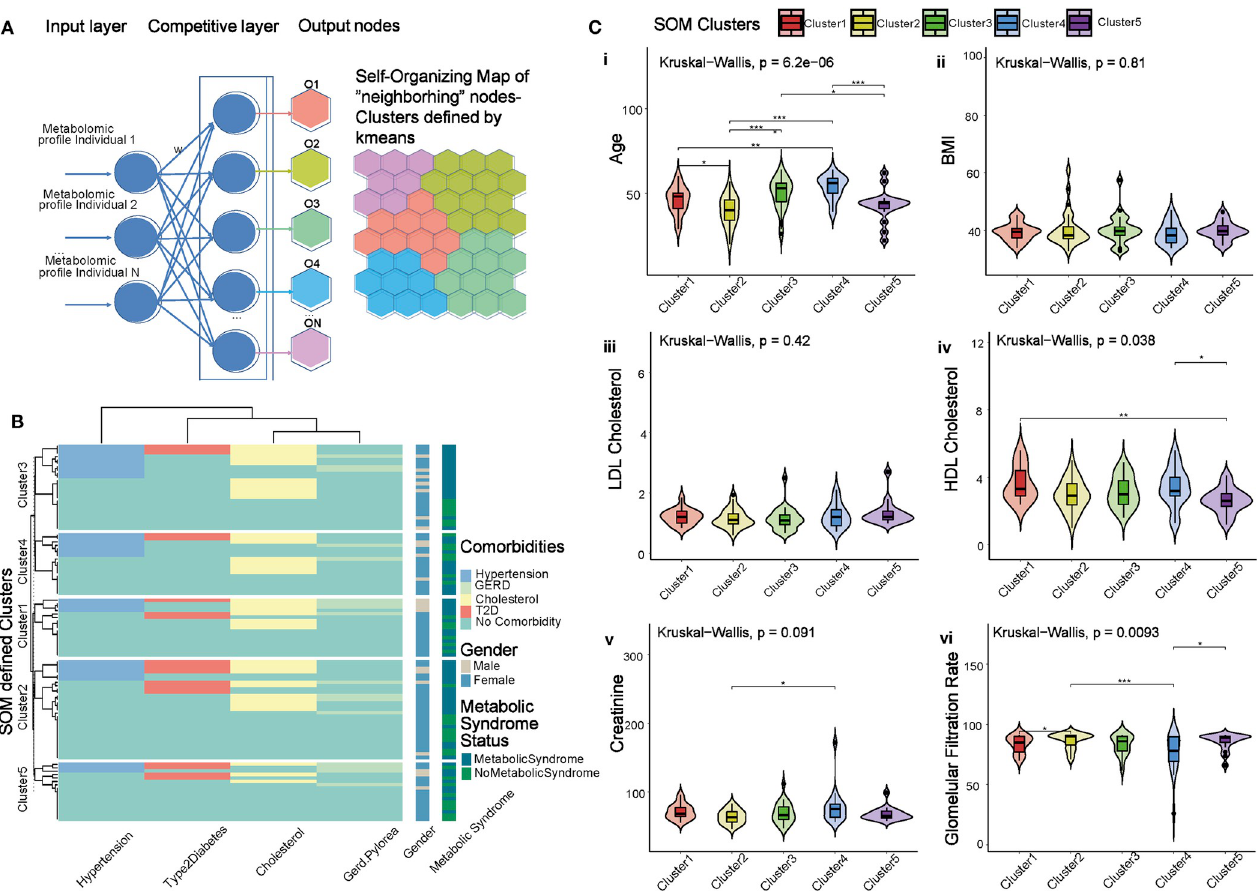
Fig 1. Self-organizing maps reveal five distinct metabotypes within BARIA cohort. (A) Architecture of a competitive artificial neural network. Each individual’s complete metabolomic profile is assigned a weight. The weights are in turn assigned to neurons in the competitive layer of the neural network. In the competitive layer, SOM algorithm calculates the similarity metric (here Euclidean distance) between each metabolomic profile and the neurons and then updates the weights. After training, the network assigns the individual’s metabolomic profile to the “winner” output node, the node that is essentially more similar to the input metabolomic profile. Once this step is complete, all the nodes are comprising the SOM. Finally, all the nodes of the SOM are subjected to k- means clustering resulting in the partitioned topology, the metabotypes (SOM & k-means defined clusters). (B) Clustergram of hierarchical cluster analysis depicting the distribution of medically treated cardiometabolic comorbidities of the individuals in each of the metabotypes (SOM & k-means defined clusters). The treated comorbidities are: hypertension, T2D, GERD and cholesterol. In parallel columns are the gender and metabolic syndrome status of each individual, respectively. (C) Clinical variables associated with obesity and their statistical significance across the metabotypes (SOM & k-means defined clusters): age (C. i), BMI (C. ii) , HDL cholesterol (C. iii), LDL cholesterol (C. iv) , creatinine and (C. v) , glomerular filtration rate (c. vi) ; statistical significance among metabotypes is calculated with Kruskal-Wallis test; the symbols indicating significance among metabotypes are ‘ � ’: P < = 0 . 05 , ‘ �� ’: P < = 0 . 01 , ‘ ��� ’: P < = 0 . 001